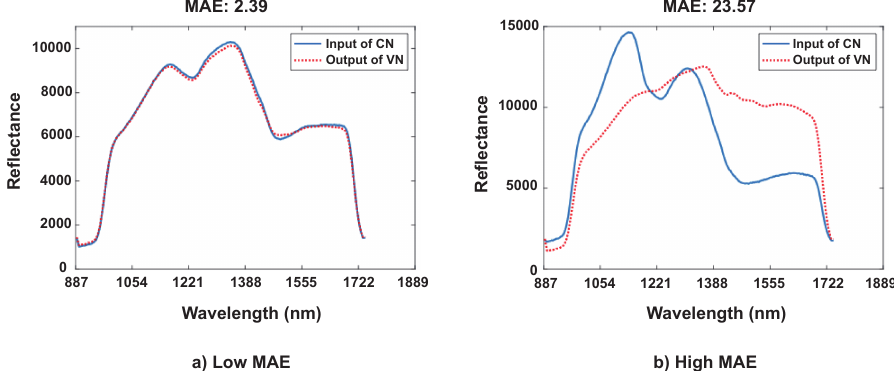
Figure 3. Typical pairs of the input of CN and the output of VN when their mean absolute error (MAE) is: ( a ) small, and ( b )